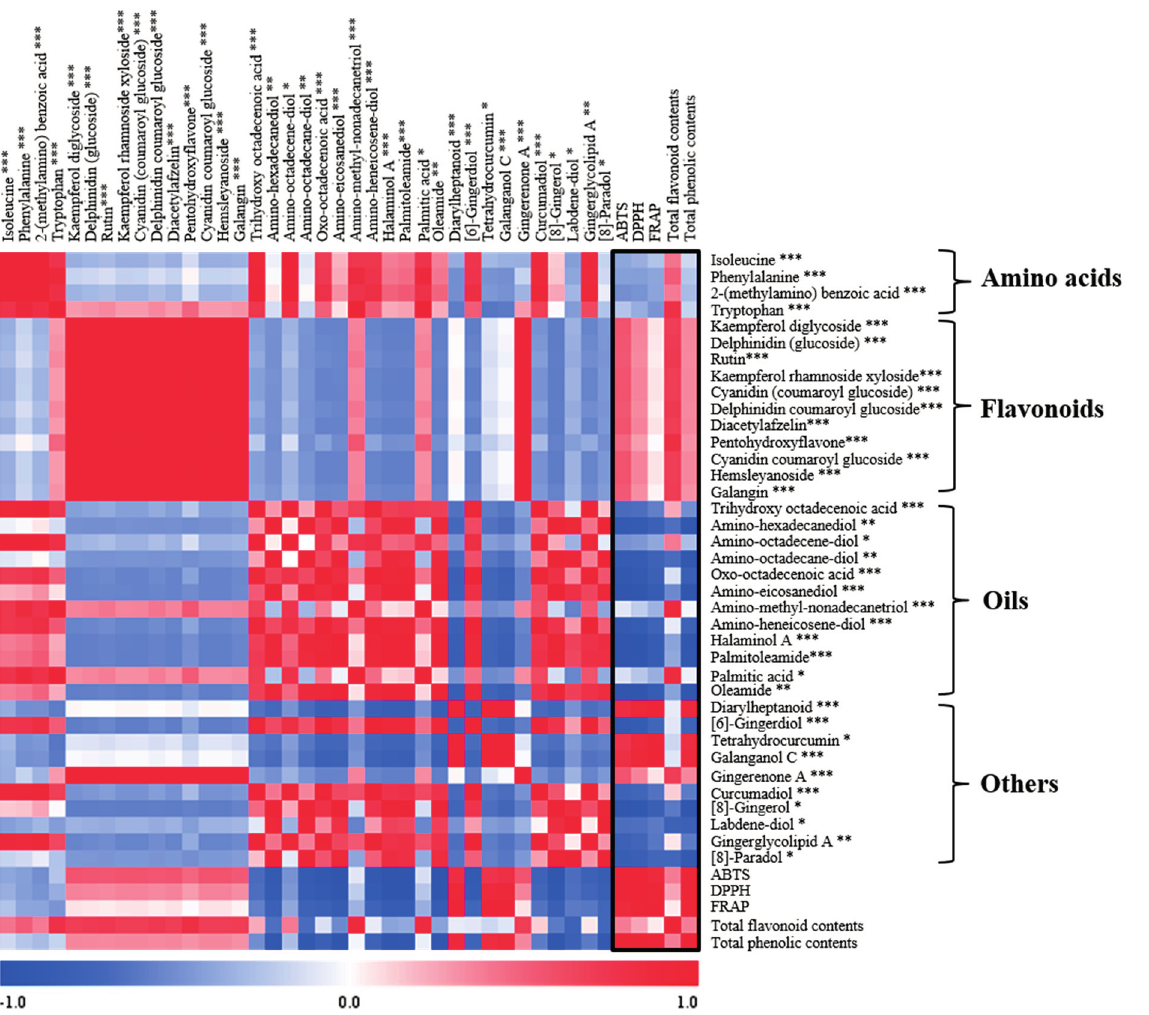
Figure 4. Correlation map of the metabolites analyzed by UPLC-Q-TOF-MS with antioxidant activity, TPC, and TFC. Each square indicates r (Pearson’s correlation coefficient values for pairs of metabolite or antioxidant activity values). The red color represents a positive (0 < r < 1) correlation and the blue color represents a negative ( − 1 < r < 0) correlation. In the tentative compounds, * represents the metabolites differentiated by VIP value 1, ** represents metabolites differentiated both by VIP value 1 and 2, and *** represents metabolites differentiated by VIP value